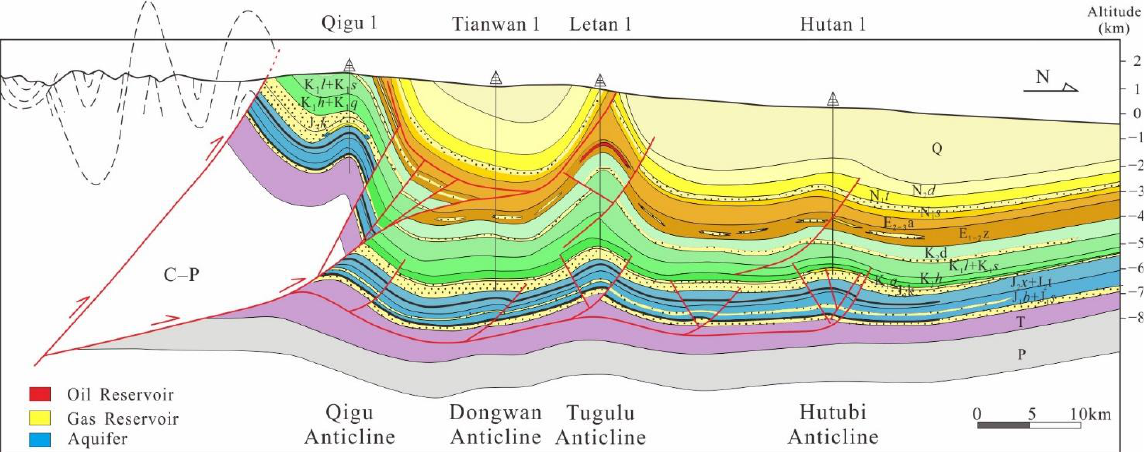
Figure 6. Hydrocarbon accumulation model in southern Junggar